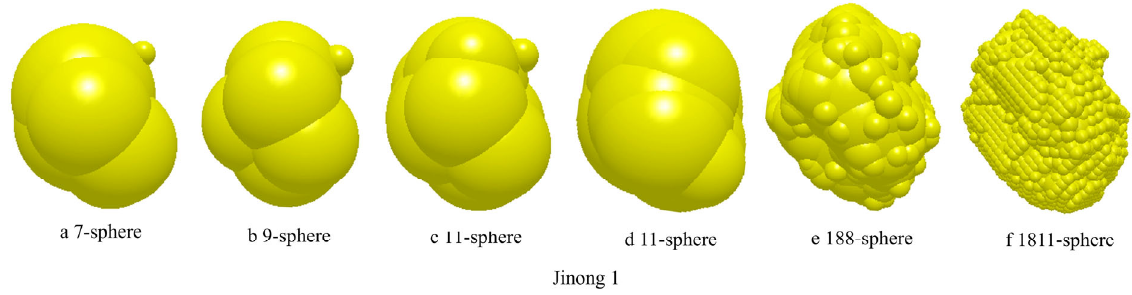
Figure 4. ( a – f ) MS models with different numbers of filing spheres for Jinong 1.